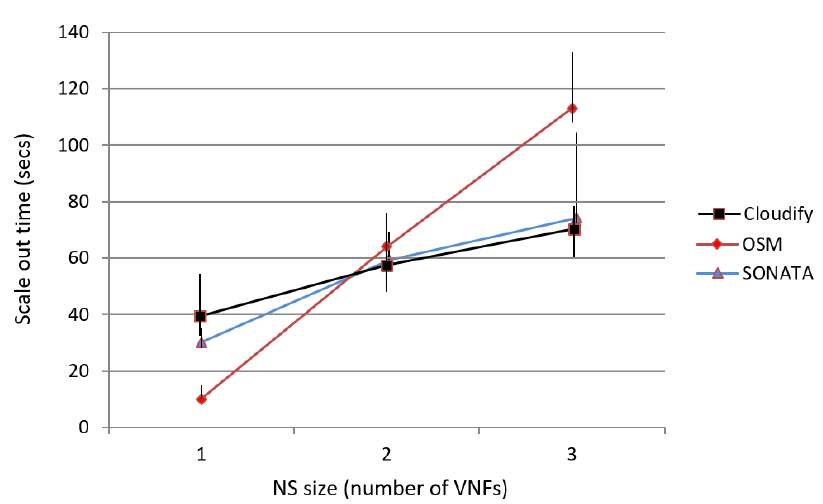
Figure 5. Average NS scaling out